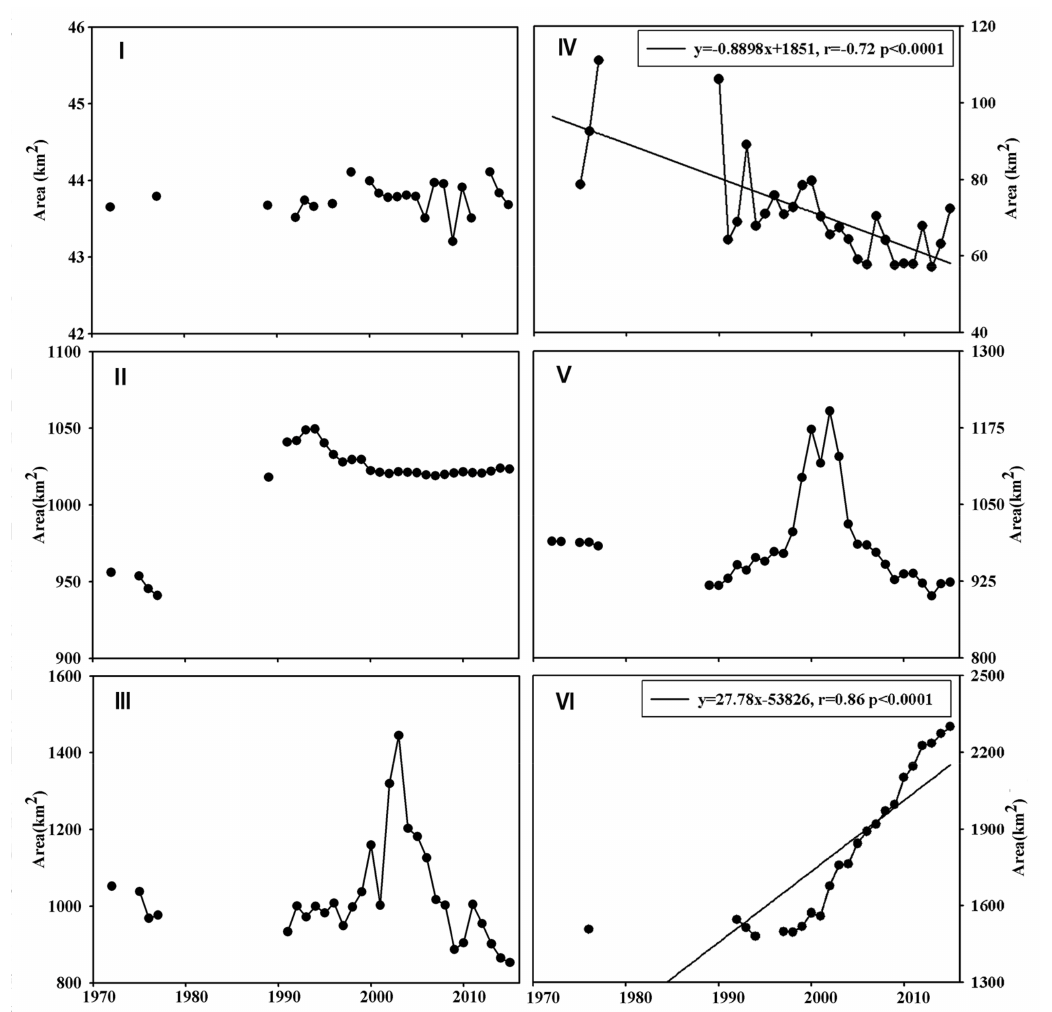
Figure 5. Inter-annual variations in lake areas in six regions from 1972 to